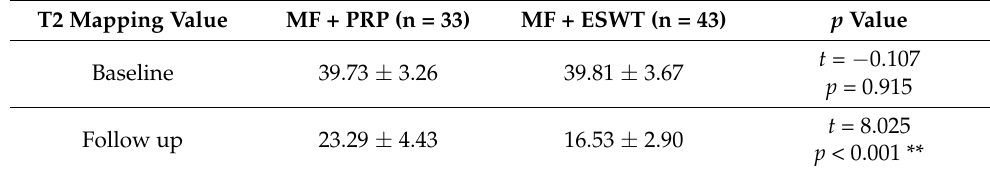
Table 3. Comparisons of the T2 mapping values in the MF + PRP and MF + ESWT groups. T2 Mapping Value MF + PRP (n = 33)